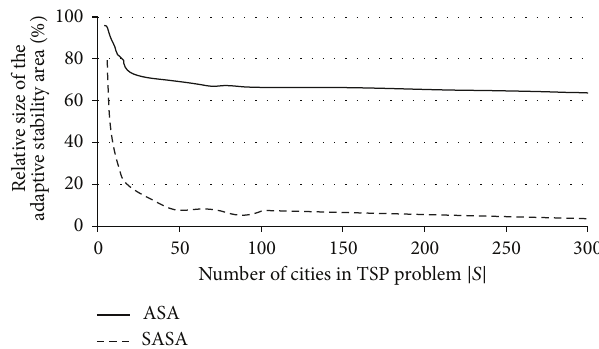
Figure 3: Dependence of the relative size of ASA (| A (𝑆)|/|𝑋|) and SASA (| A s (𝑆)|/|𝑋|) from the number of cities in an optimal tour. For each value of |𝑆| from the set {5, .. ., 21, 30, 40, 50, 60,70, 80, 90, 100, 150, 200, 250, 300} 100 random (uniform) placements of |𝑆| cities in the set 𝑋 = 1,100 × 1, 100 were performed. The functions on the graph are linear interpolations of the corresponding mean values over each 100